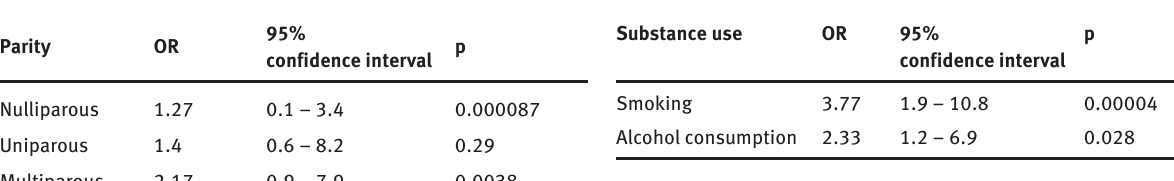
Table 7: The risk of developing ovarian cancer, taking into account the parity of patients.